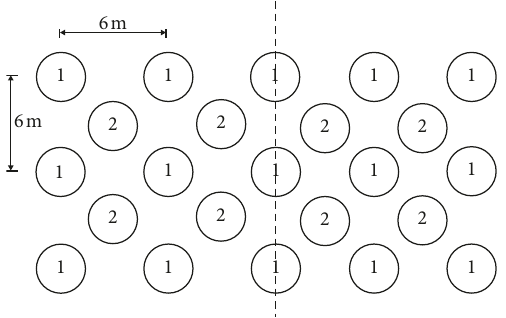
Figure 2: The tamping point floor plan.